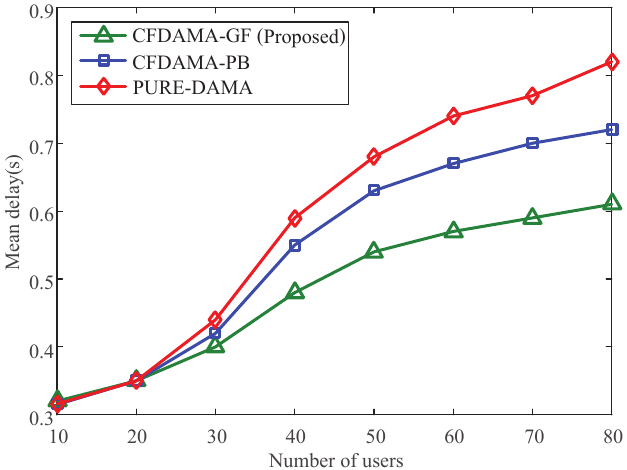
Figure 6. Comparison of average delay and number of